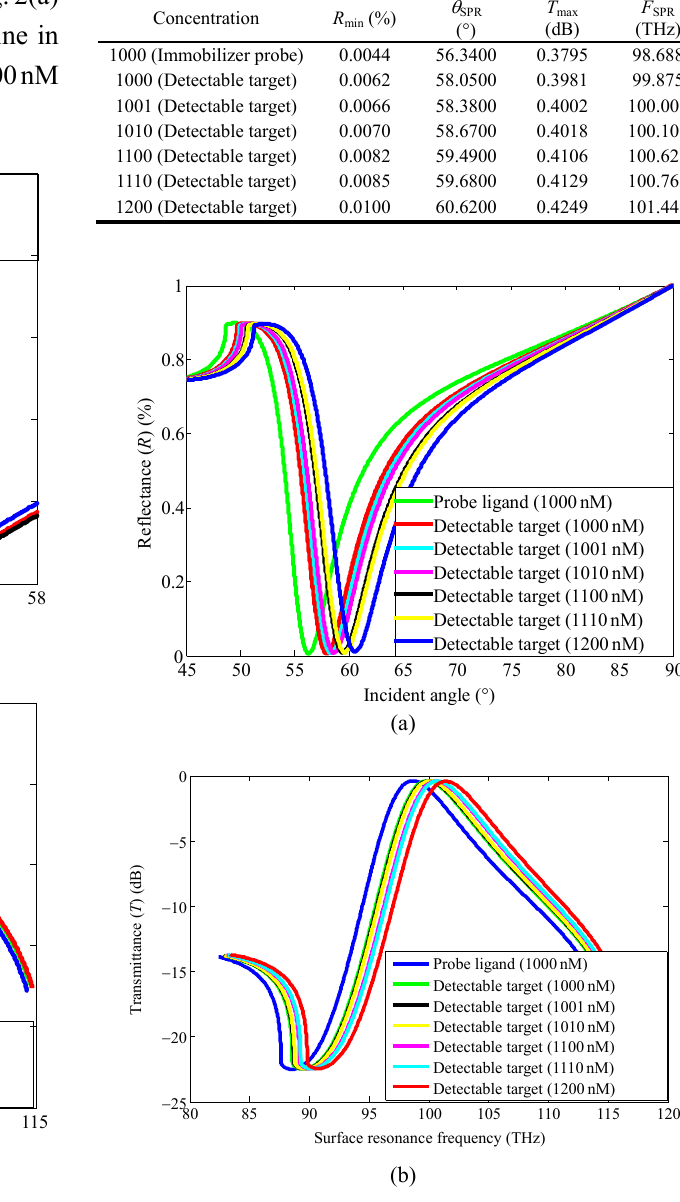
Fig. 3 SPR imaging curve of proposed sensor: (a) R ~ θ SPR curves and (b) T ~ F SPR curves for different concentrated detectable